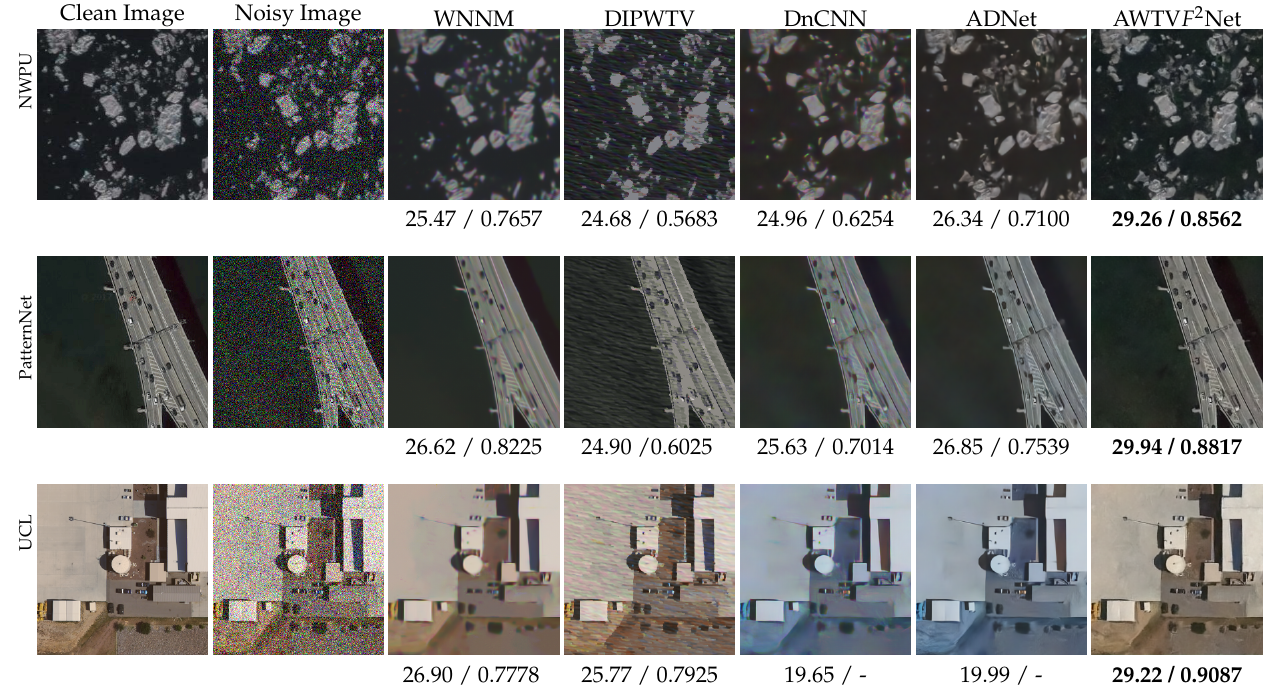
Figure 11. Visual results on NWPU, PatternNet and UCL datasets with noise level σ 2 =